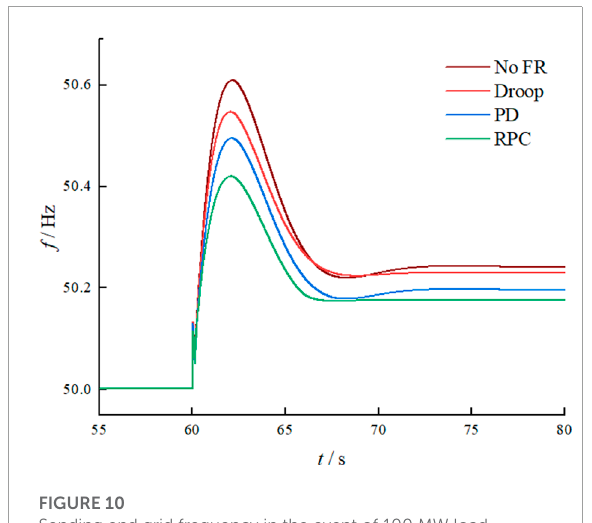
FIGURE 11 Sending end grid frequency in the event of continuous load